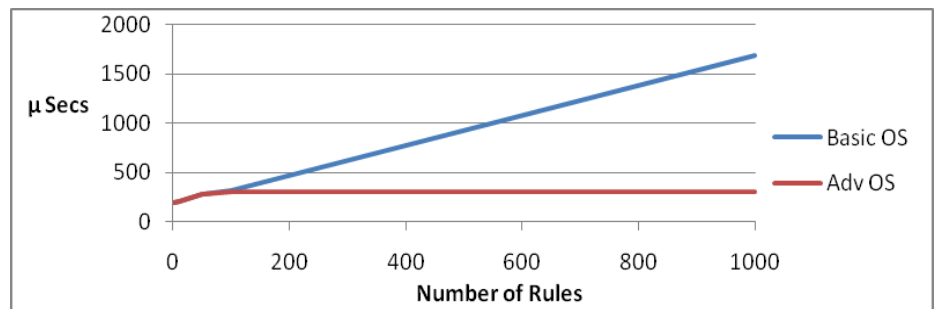
Figure 6. Delay vs. number of